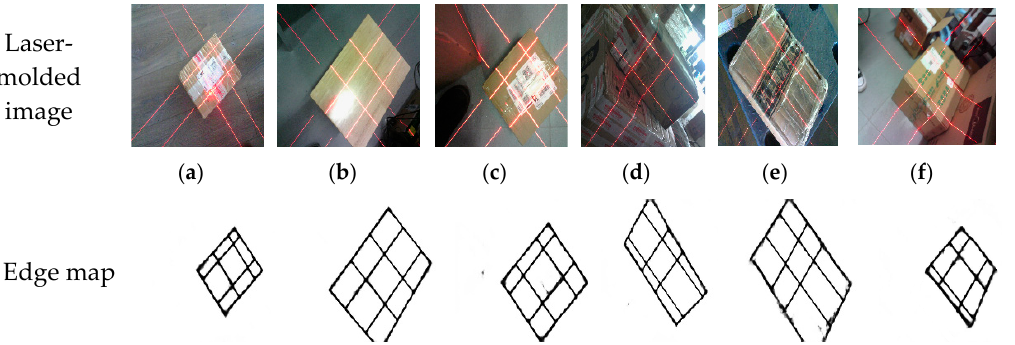
Figure 23. Image processing by our algorithm; ( a ), ( b ) and ( c ) exhibit the images captured at different optical quality; ( d ), ( e ) and ( f ) exhibit the images captured the boxes with surface variation.